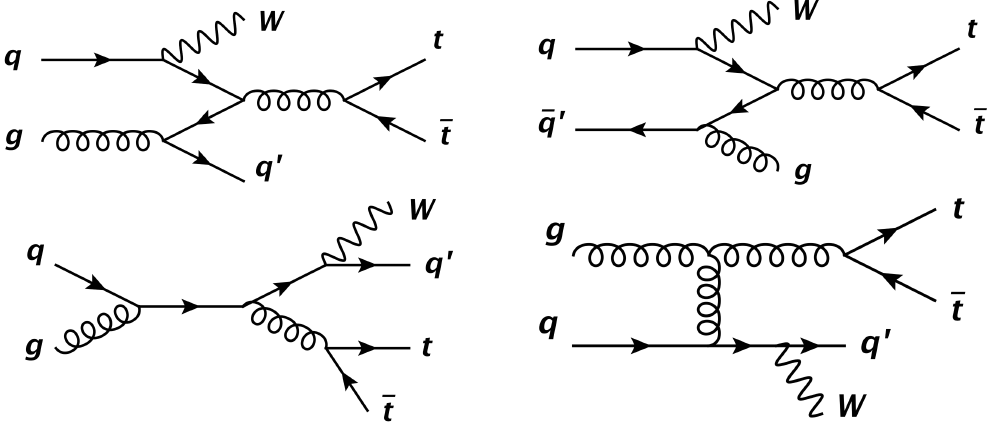
Figure 1 . Representative Feynman diagrams entering the O ( α 3 configurations, where the extra emission is a j